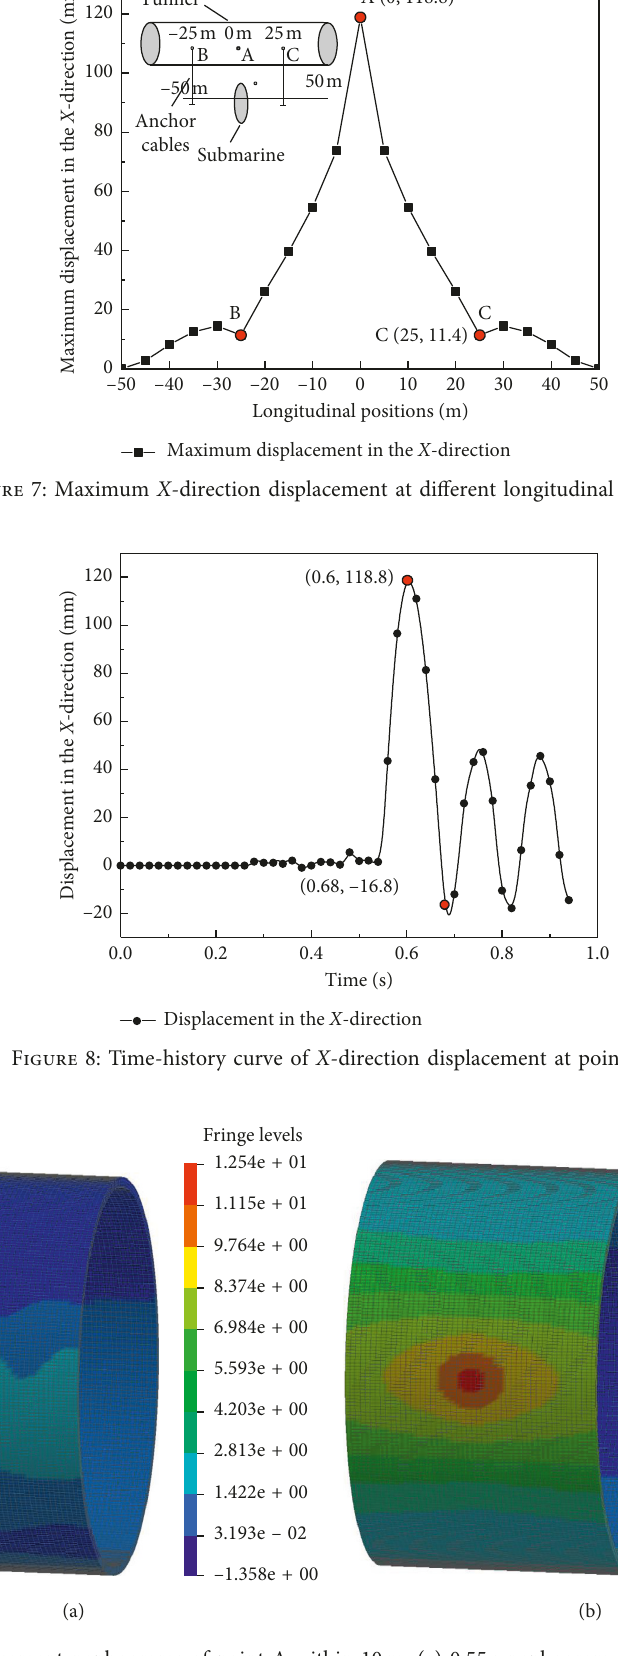
Figure 9: Displacement nephograms of point A within 10 m. (a) 0.55 s nephogram. (b) 0.60s